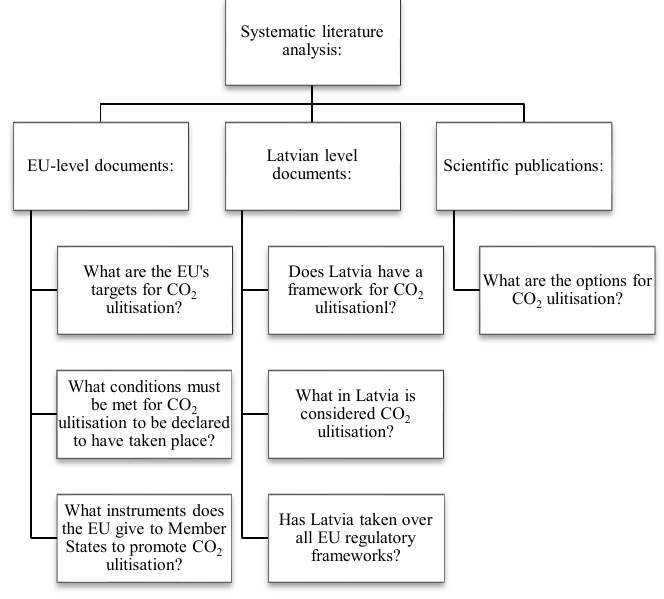
Fig. 1. Systematic literature analysis